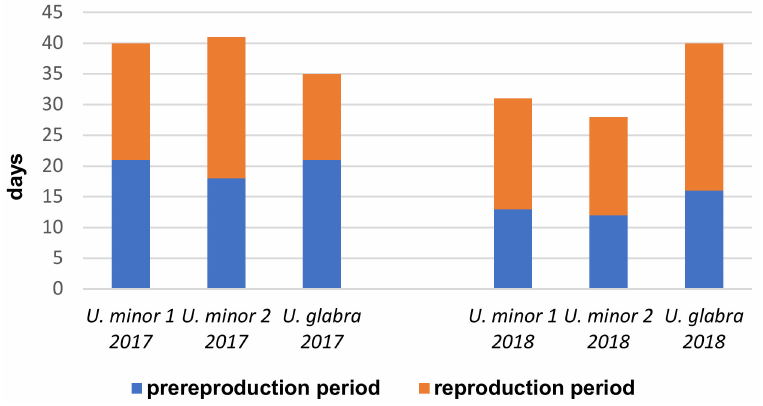
Figure 1. The duration of subsequent developmental stages of T. nigriabdominalis fundatrices on. U. minor and U. glabra ( U. minor 1, study area in Pozna´n; U. minor 2, study area in Rzesz ó w).